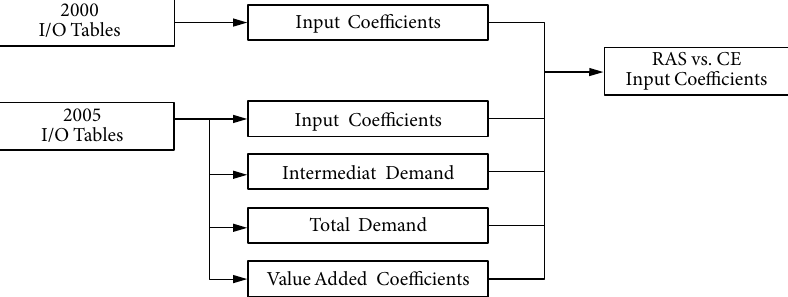
Fig. 1. Steps in comparison of RAS and CE